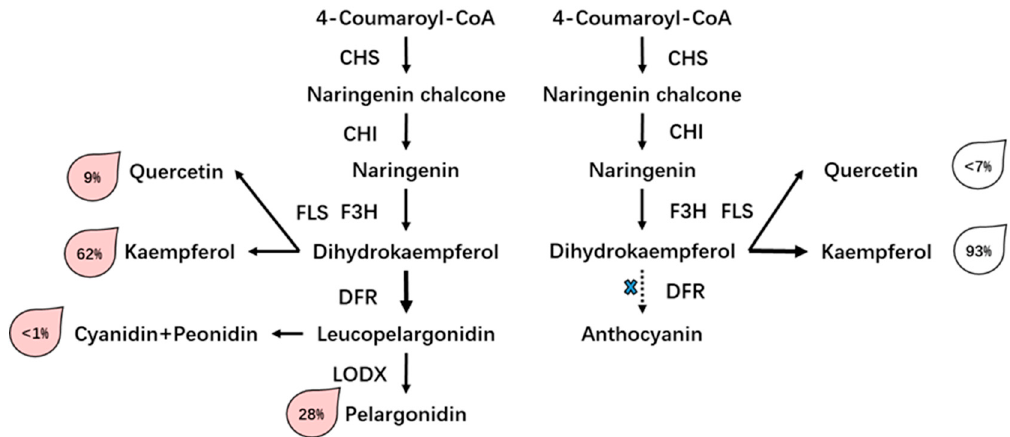
Figure 8. A putative model of the biosynthesis process of pigment accumulation in two rose varieties. The expression of DFR is switched off, and the substrate used for anthocyanin synthesis is shunted to flavonol synthesis; hence, FLS is up-regulated in the white flowers. The total output of flavonoids and anthocyanins was considered to be 100% and was used to evaluate the relative level of each product.